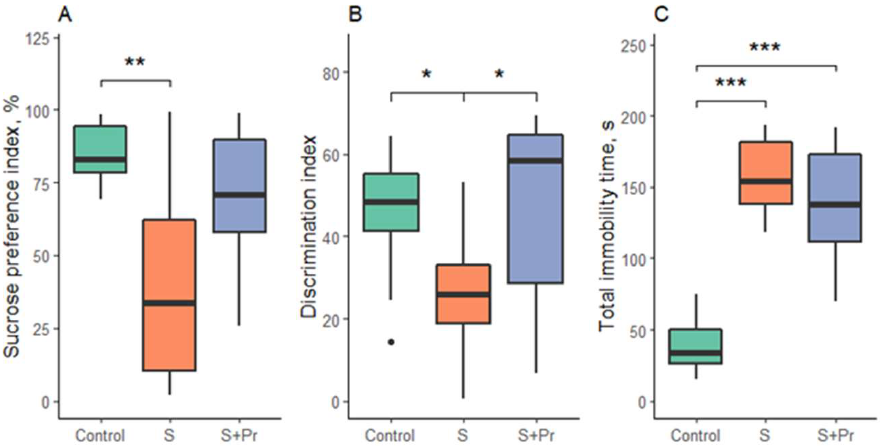
Figure 6. Behavioral test results: ( A )—sucrose preference test; ( B )—new object recognition test; ( C )—forced swim test. S-chronic ultrasound stress group, S + Pr—group of rats exposed to chronic ultrasound stress with protein aerogel nasal treatment. Black circles—outliers; *— p < 0.05, **— p < 0.01, ***— p <